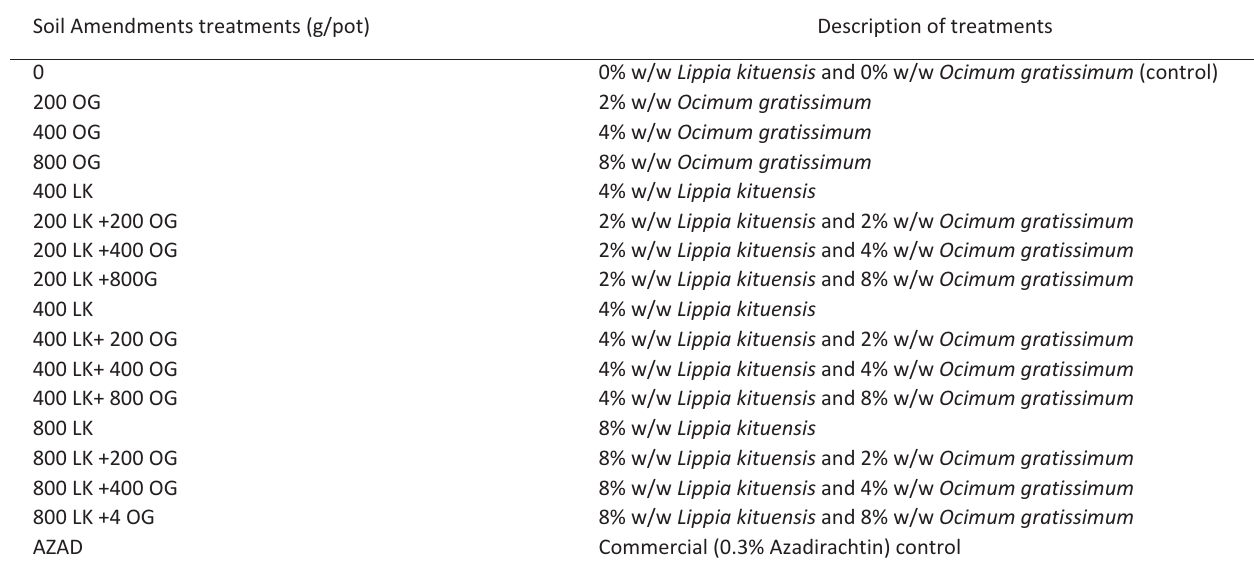
OG= Ocimum gratissimum L. (g/10 kg soil); LK = Lippia kituensis Vatke (g/10 kg soil), are soil organic amendments; 0 = no amendment; AZAD = positive control of commercially know pesticide